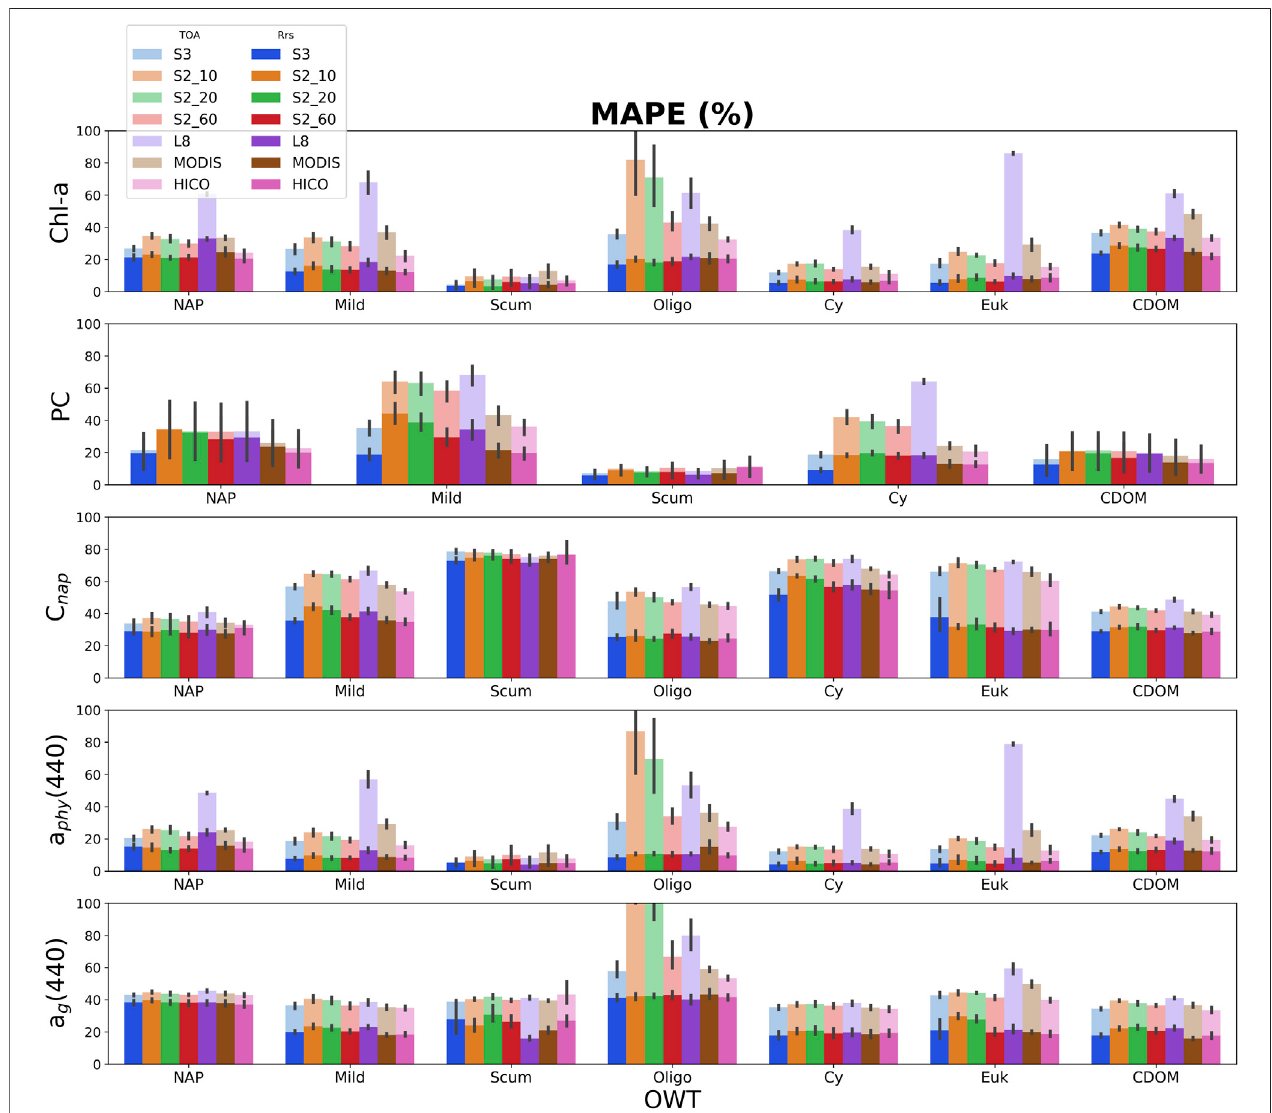
FIGURE 6 | Median absolute percent error (MAPE) for MLP derived products (from top-to-bottom: chl-a, PC, and NAP concentrations, absorption of phytoplankton, and a g at 440 nm). Retrieval errors using R rs are in solid bright colors, while retrieval errors using TOA re fl ectance are stacked in corresponding opaque colors. Lower MAPE corresponds to better performance. Error bars represent the standard deviation for the fi ve-fold cross